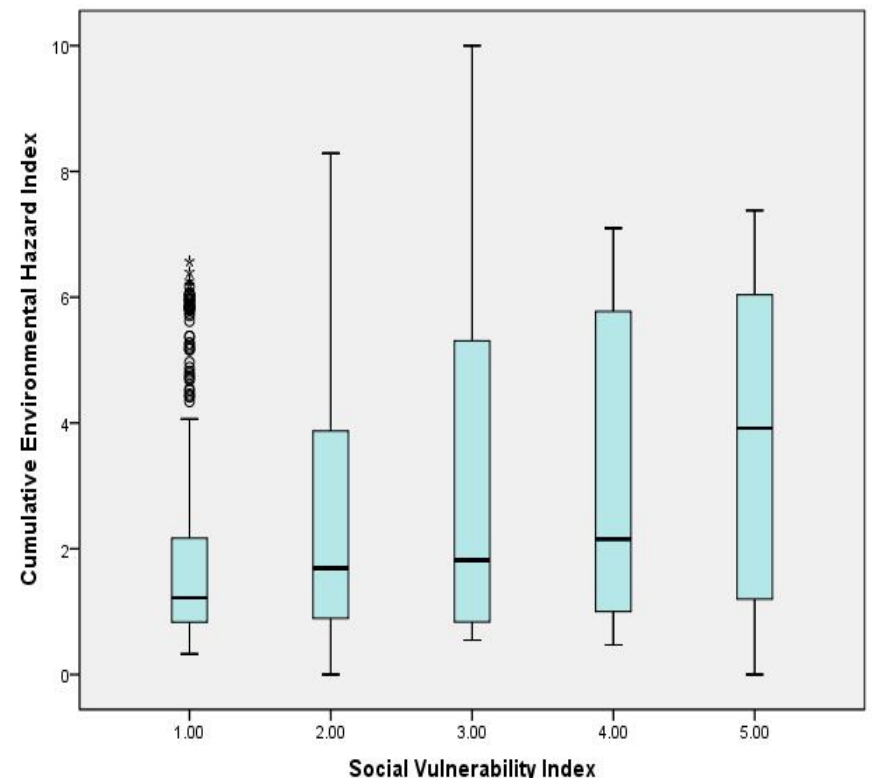
Figure 2. Box plot of CEHI and